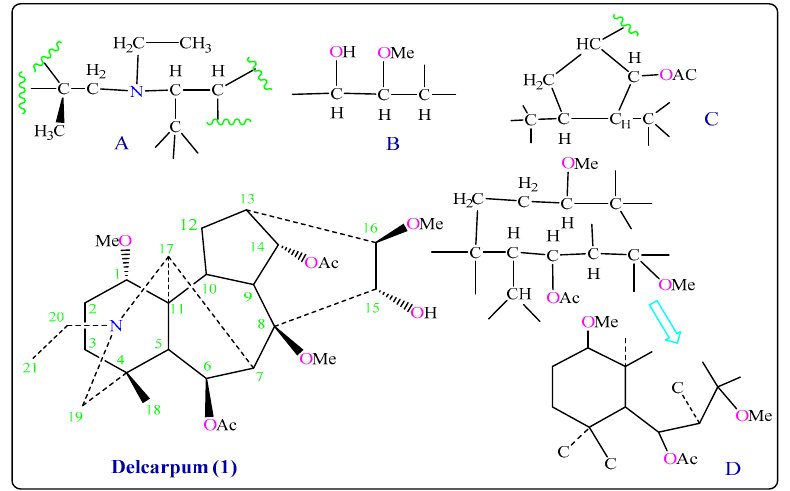
Figure 2. Partial structures of Delcarpum ( 1 ).